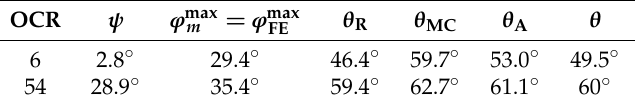
Table 4. Inclination of final shear